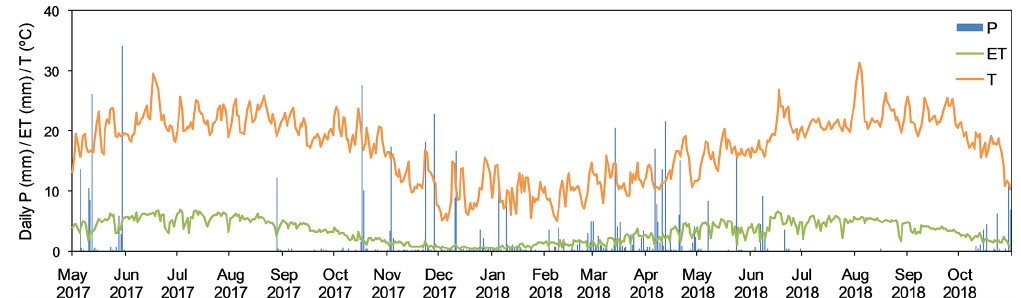
Figure 2. Distribution of daily precipitation ( P ), reference evapotranspiration ( ET ), and mean temperature ( T ) recorded at the meteorolog- ical station located in the study area during the study